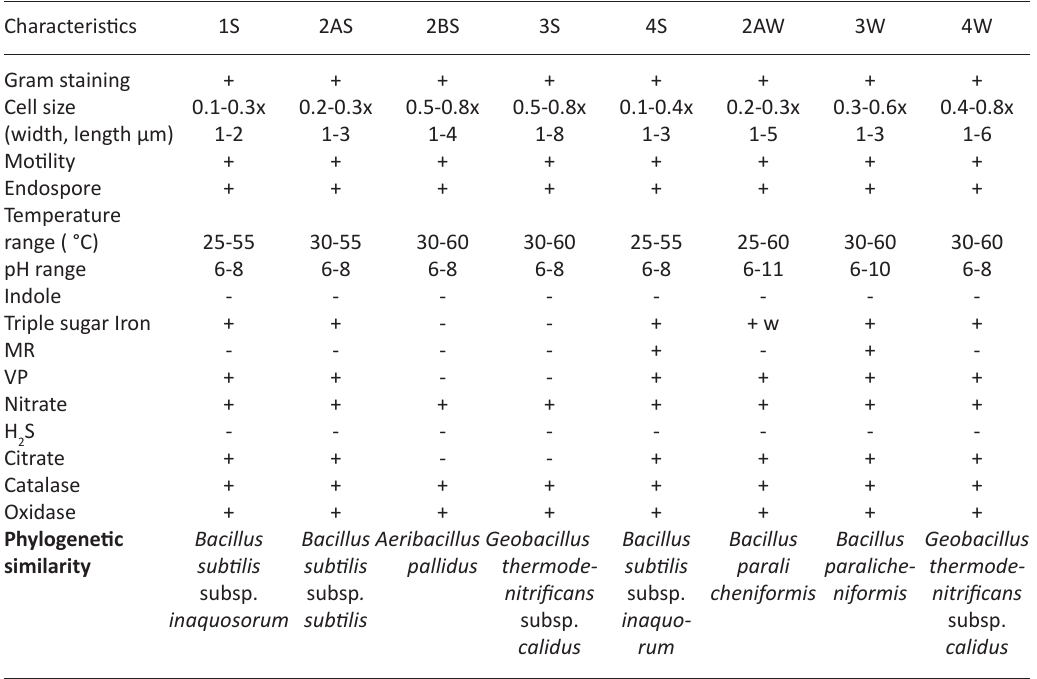
Table 3. Biochemical characterization and phylogenetic relatedness of strains isolated from Thar Desert Characteristics